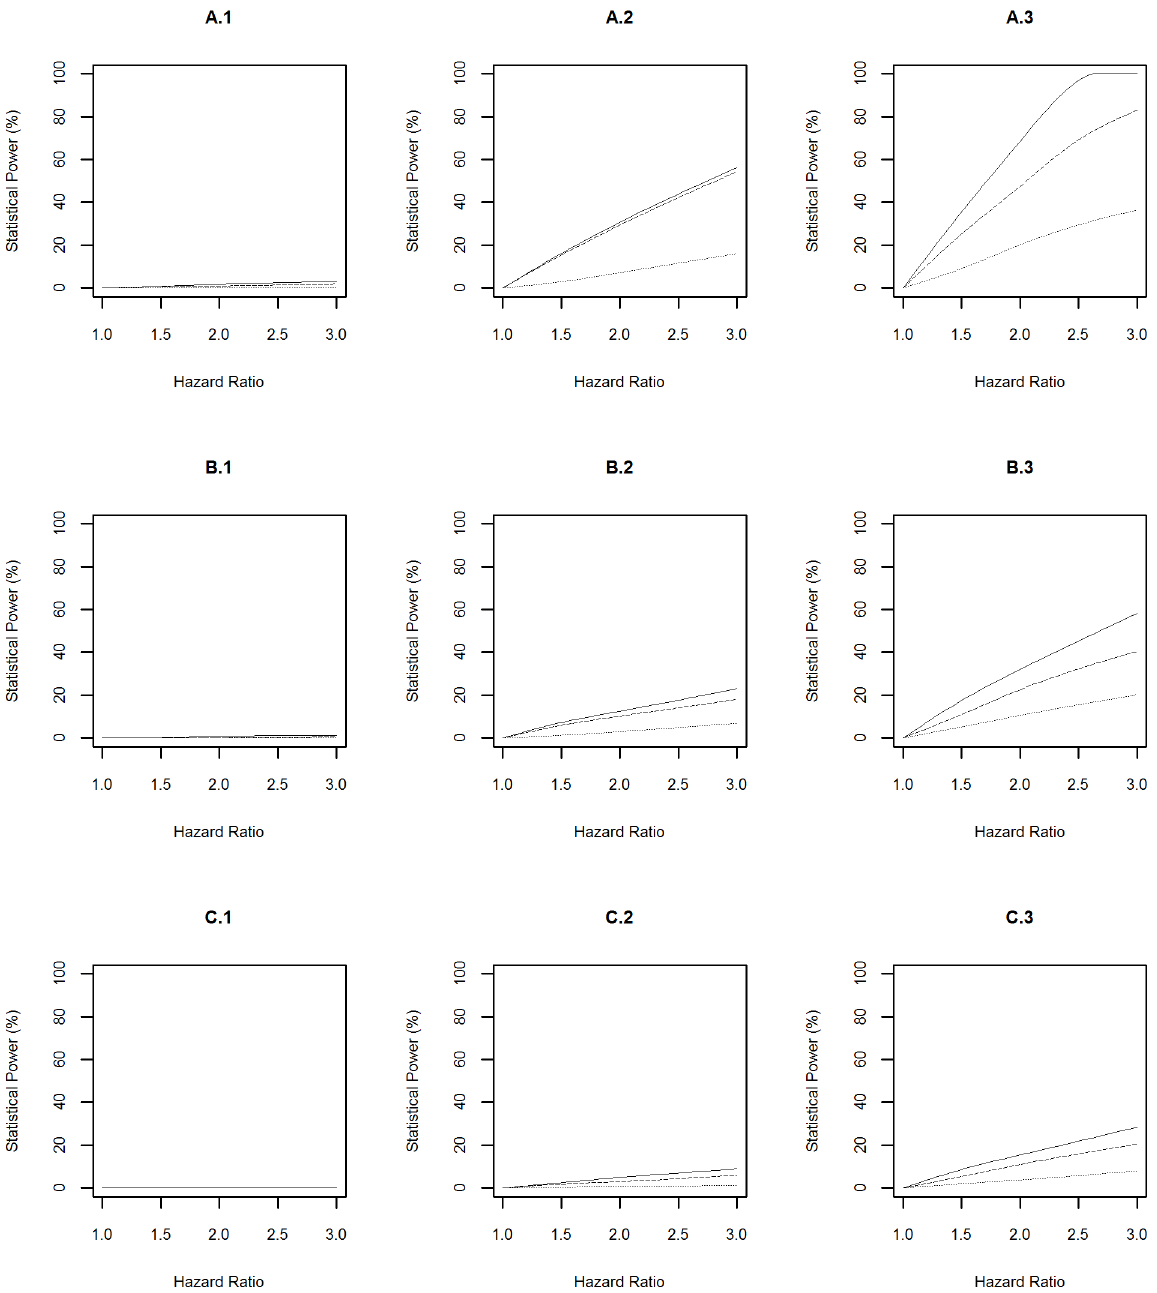
Fig 6. Power Profile at Significance Level of 5×10 − 8 for Gene-Environment Interaction. “ A ” , “ B ” and “ C ” represent diabetes, dementia and Parkinson ’ s disease respectively. “ 1 ” , “ 2 ” and “ 3 ” represent that both environmental and genetic risk factors are rare (prevalence = 0.01), common (prevalence = 0.1), and very common (prevalence = 0.2) respectively. The solid, dashed and dotted lines represent the statistical power profile of the study assuming subjects undergo health monitoring continuously, subjects undergo repeated measures every three years, and subjects undergo repeated measures every three years and the both environmental and genetic risk exposures are subject to measurement error (0.1 for environmental risk exposure and 0.01 for genetic risk exposure)